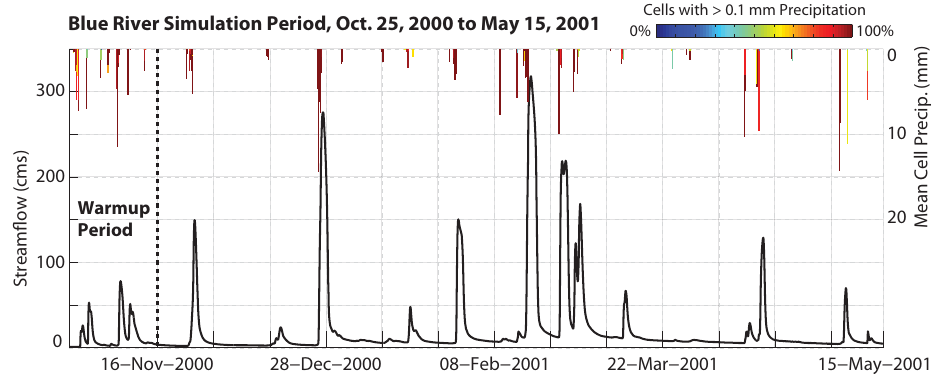
Fig. 2. The hourly hydrograph of the 6 month simulation period for the Blue River basin, with a 3 week warm up period. The precipitation amounts are based on the mean value across the 78 HRAP grid cells in the basin. The colors of the precipitation bars indicate the fraction of grid cells receiving more than 0.1mm precipitation, representing the spatial distribution of each hourly rainfall